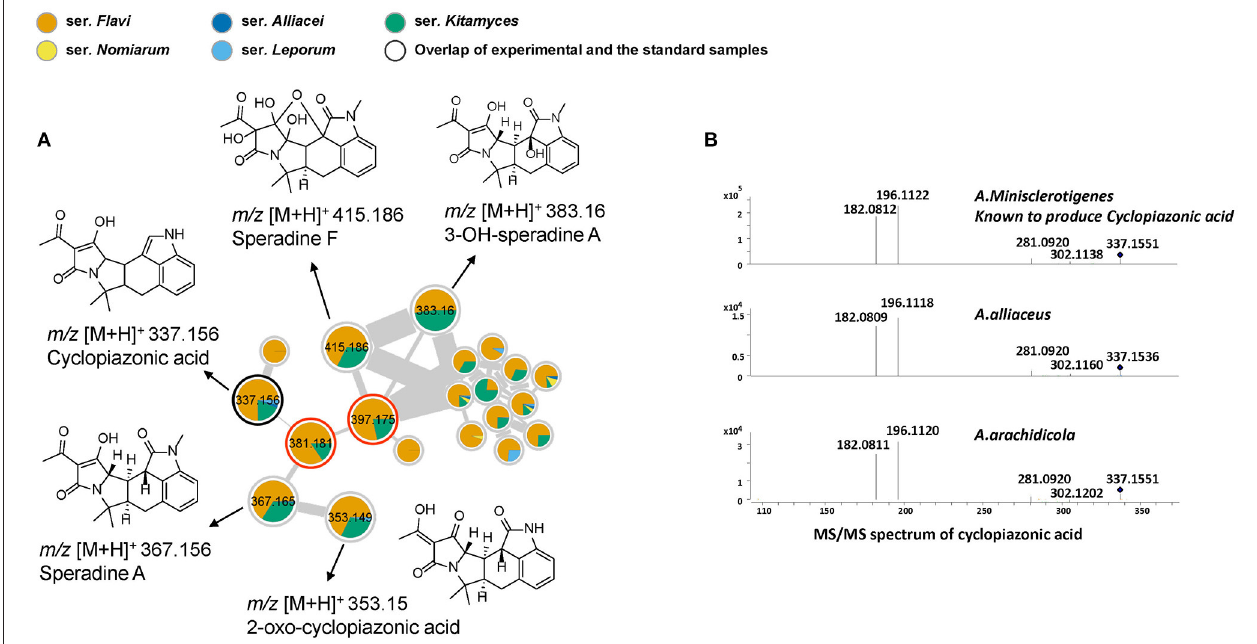
FIGURE 4 | (A) Nodes of the compounds related to the cyclopiazonic acid biosynthetic family. Nodes with bold outlined black circles are the overlap of molecules and the standard compounds, the nodes marked with asterisk are the molecules found from the structural relationship shown in molecular networks and the nodes with red outline represent the potentially novel compounds. (B) MS/MS spectrum of cyclopiazonic acid (CPA). A. minisclerotigenes is the cyclopiazonic acid-producer according to the previous study (Chang et al., 2009). A. alliaceus and A. arachidicola confirmed as two new CPA producing species by comparing the MS/MS spectra of both strains with known cyclopiazonic acid